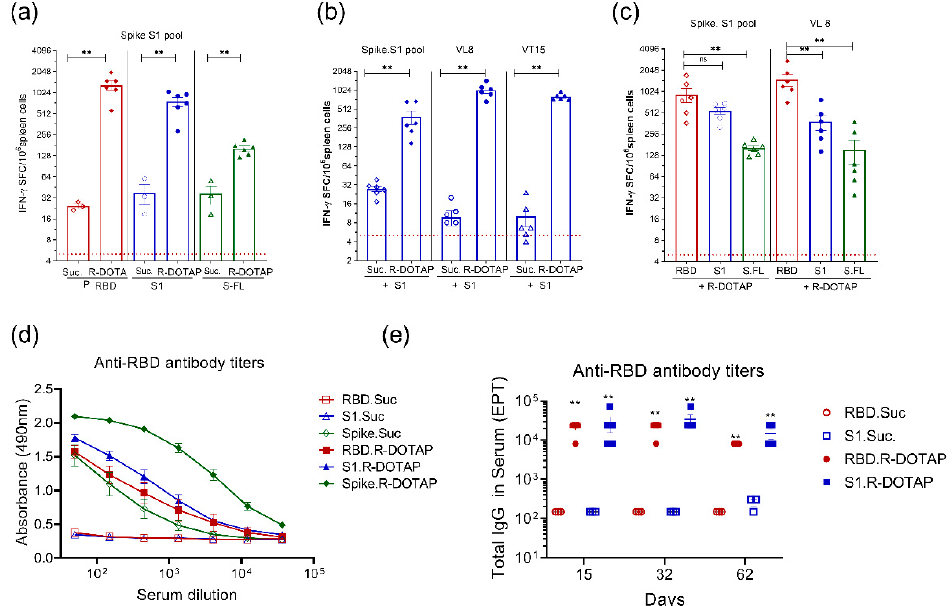
Figure 1. Recombinant SARS-CoV2 spike protein formulated with R-DOTAP nanoparticles induced potent T-cell and antibody-mediated immune responses. Groups of C57BL6/J mice ( n = 5) ( a – d ) were subcutaneously immunized on day 0 and day 7 with 0.1 mL vaccine formulations containing SARS- CoV2-derived recombinant spike RBD domain (RBD), Spike S1 domain (S1), or Spike full-length protein (spike) formulated with R-DOTAP or sucrose buffer (Suc). Each mouse received a vaccine formulation containing 10 µ g protein/dose ( a , b , d ) (equal weight basis) or estimated 750 nM pro- tein/dose (equal molar concentration) ( c ) of indicated recombinant protein antigens. Splenocytes ( a – c ) isolated 7 days after second vaccine were stimulated overnight with pools of overlapping peptides (1 µ g/peptide/mL) (S1pool) derived from SARS-CoV2 Spike S1 domain or VL8 CD8 T-cell epitope (10 µ g/mL) or VT15 CD4 T-cell epitope (10 µ g/mL) and IFN- γ producing cells in spleens from vaccinated mice were measured using an ELISpot assay. Data represent mean ± SEM spot forming cells (SFC) in each mouse. Dotted lines in each figure represent average SFC count in the background no peptide wells. Serum samples from the same group of mice shown in ( a ) were ob- tained on day 14 ( d ) and assayed for anti-RBD total IgG by ELISA. Serum samples from BALB/c mice ( e ) vaccinated on days 0 and 7 were obtained on days 15, 32, or 62 and assayed for anti-RBD total IgG antibody by ELISA. Data ( d ) represent mean ± SEM of relative absorbance (OD) at 490 nm. Data ( e ) represent mean ± SEM end point titer (EPT) from each mouse. Comparisons between su- crose alone or R-DOTAP groups ( a – c , e ) was performed using Student’s t -test (unpaired-two tailed). ** p ≤ 0.05 ns p ≥ 0.05. Data shown are representative of three independent repeat studies.